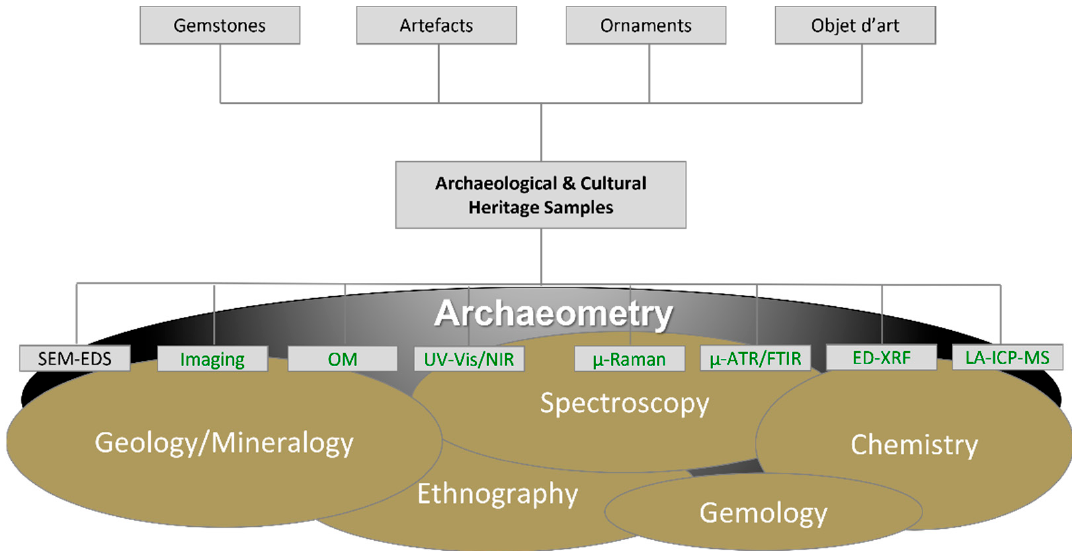
Figure 1. Archaeometry requires a multidisciplinary approach to characterize archaeological and cultural heritage samples. Gemstones, artefacts, ornaments, and objets d’art, with several exceptions, belong to archaeological and cultural heritage samples. To identify and characterize these type of samples, in an archaeometric context, the contributions of different expertise are required, including geologists, mineralogists, etc. Moreover, many analytical techniques are necessary. The acronyms correspond to: SEM-EDS: Scanning Electron Microscopy with Energy Dispersive Spectroscopy; OM: Optical Microscopy; UV-Vis/NIR: Ultraviolet-Visible/Near-InfraRed spectroscopy; µ-Raman: micro-Raman Spectroscopy; µ-ATR/FTIR: micro-Attenuated Total Reflection/Fourier Transform InfraRed Spectroscopy; ED-XRF: Energy Dispersive X-ray Fluorescence; LA-ICP-MS: Laser Ablation Inductively Coupled Plasma Mass Spectrometry. Imaging techniques: the term “imaging” is commonly used for diagnostics-per-image systems, which typically include multispectral observation (i.e., imaging by fluorescence reaction, Wood lamp, etc.). It is interesting to note that all techniques reported by the green color in the gray boxes are typically applied in scientific gemology .